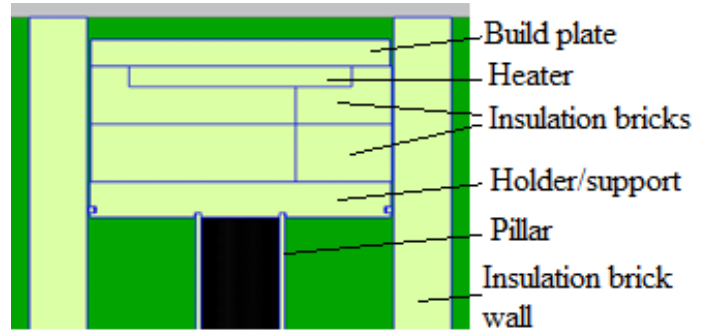
Figure 18. Front view of HeatGenPro concept.